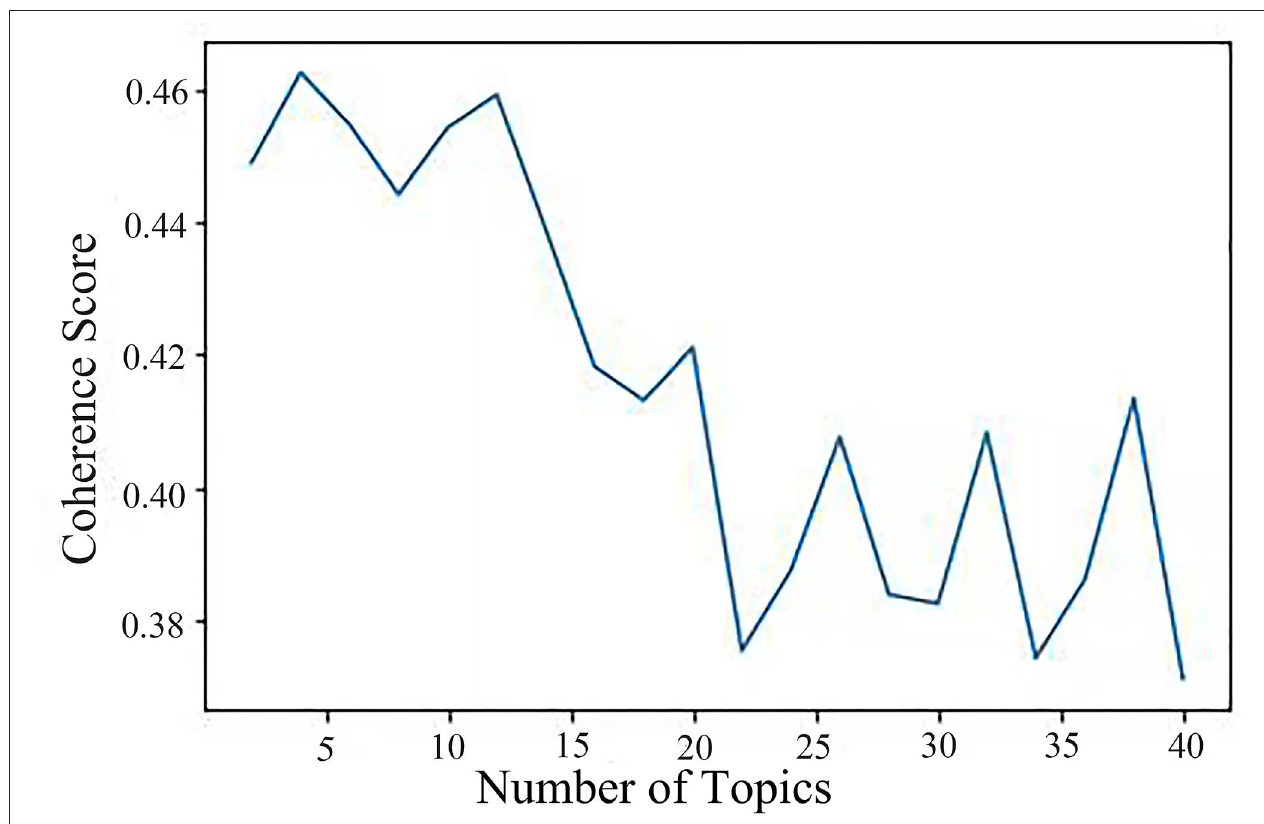
FIGURE 2 | Coherence score.